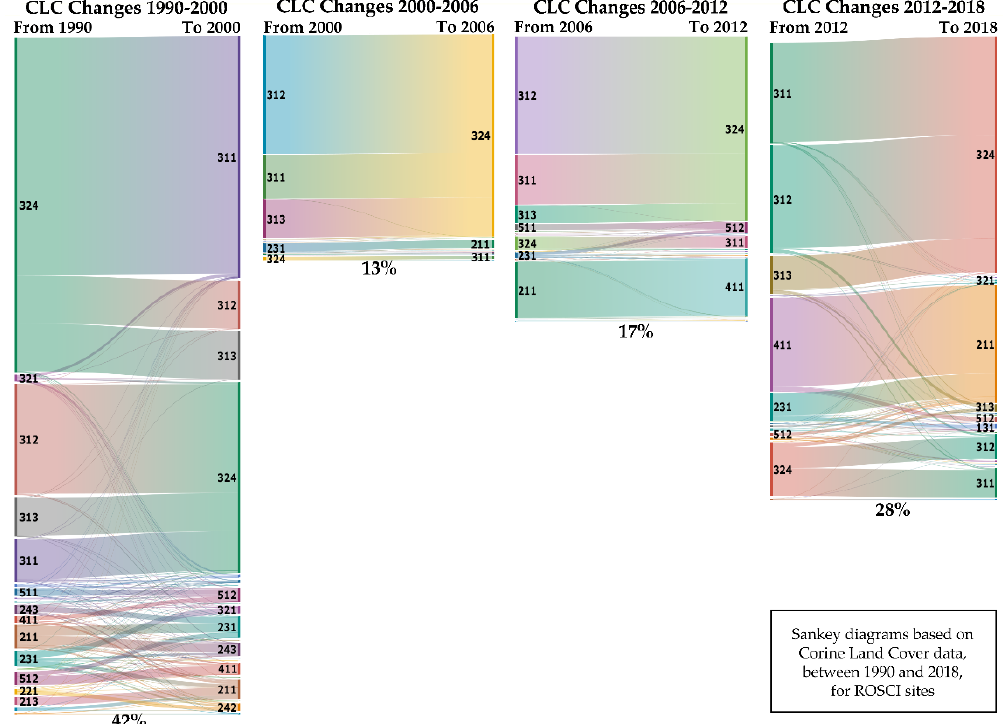
Figure 5. Corine Land Cover (CLC) dynamics within ROSCI sites (1990–2018) (the numbers that are mentioned in the graph refer to the land cover codes according to the CLC classification; their description is detailed in the Materials section).